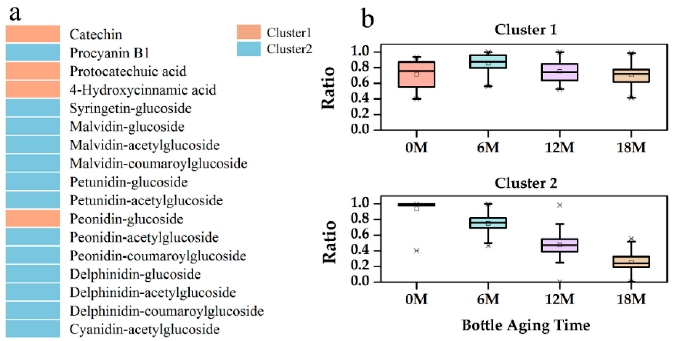
Figure 1. Statistical clustering for change trends of phenolic compounds in all rosé wines during an 18-month bottle aging. ( a ) General phenolic profile of rosé wines; ( b ) phenolic compounds’ change trends.